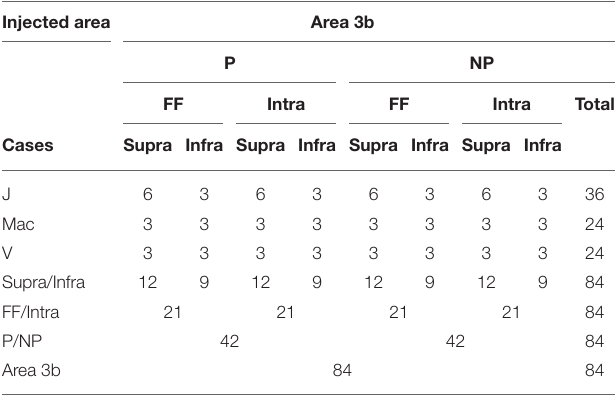
TABLE 2 | Total number of reconstructed axons labeled by area 1 injection in the different studied pathways. Injected